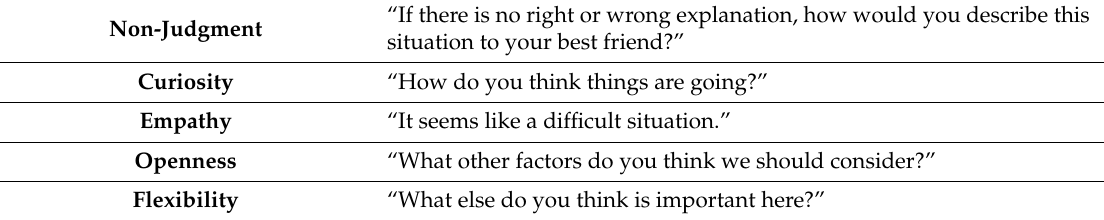
Table 1. Coaching Stance: The Five Factors.